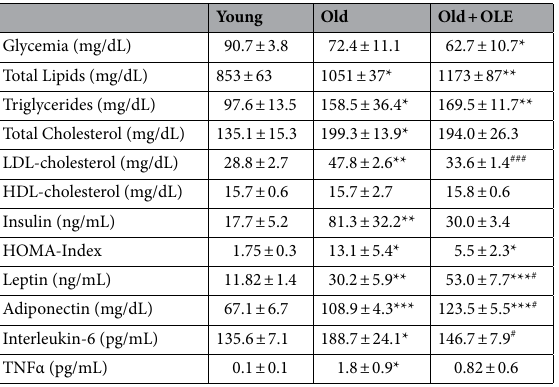
Table 3. Lipid profile, hormone concentrations and inflammatory parameters in the serum of young rats, old rats and old rats treated with olive leaves extract (OLE). Data are represented as mean value ± SEM; n = 6–11 samples/group. * p < 0.05 vs. Young; ** p < 0.01 vs. Young; *** p < 0.001 vs. Young; # p < 0.05 vs. Old; ### p < 0.001 vs.